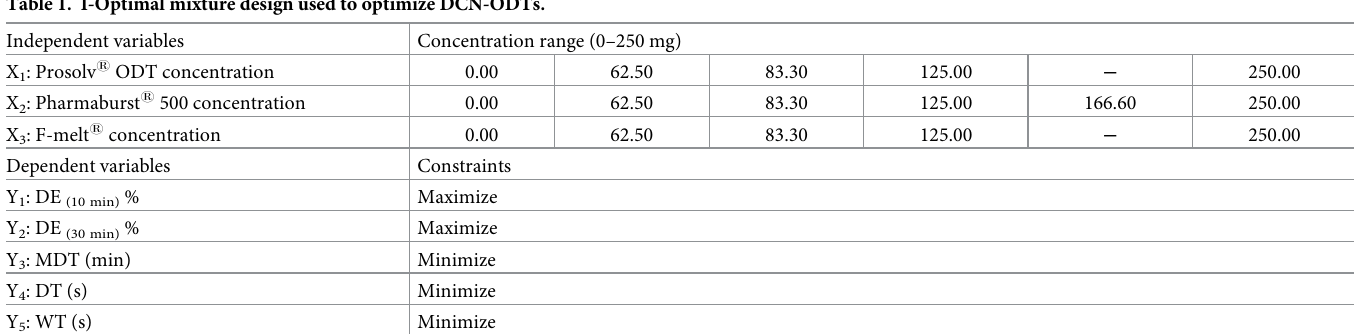
Table 1. I-Optimal mixture design used to optimize DCN-ODTs. Independent variables